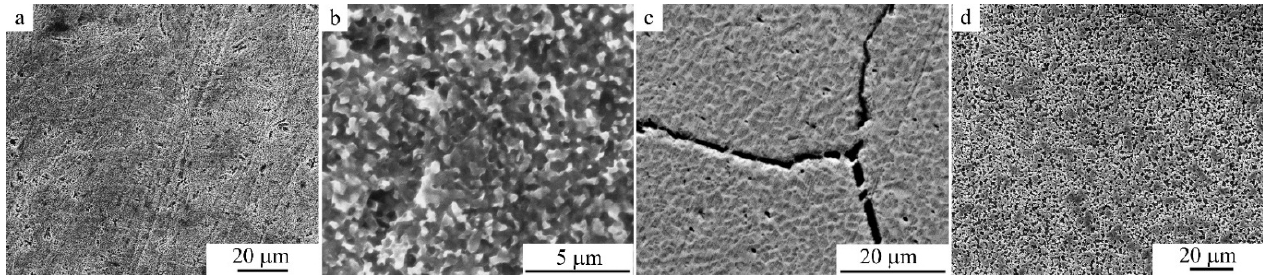
Figure 24. SEM images in SE mode of the intragrain microstructure in the Cu-14Al-4Ni alloy after the compression tests at ( a , b ) 773 K ( v = 1 mm/min) and ( c , d ) 873 K (( c )— v = 5, ( d )— v = 1 mm/min) [47].